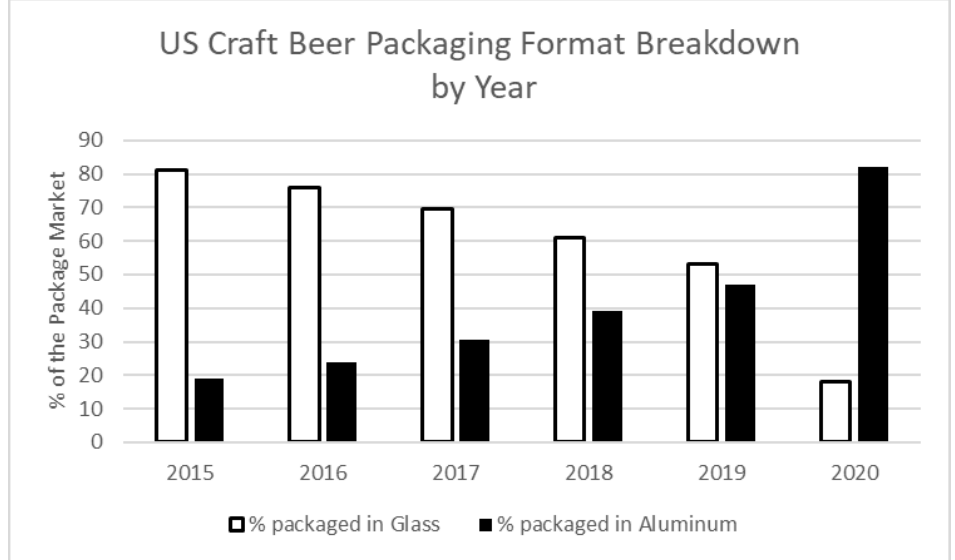
Figure 1. The above figures showcase the annual packaged production by craft breweries per year Figure 1 . The above figures showcase the annual packaged production by craft brewer- since 2015. Additionally, shown are the percentage breakdown of the packaging format styles per ies per year since 2015. Additionally, shown are the percentage breakdown of the pack- year when comparing glass to aluminum aging format styles per year when comparing glass to aluminum packaging.